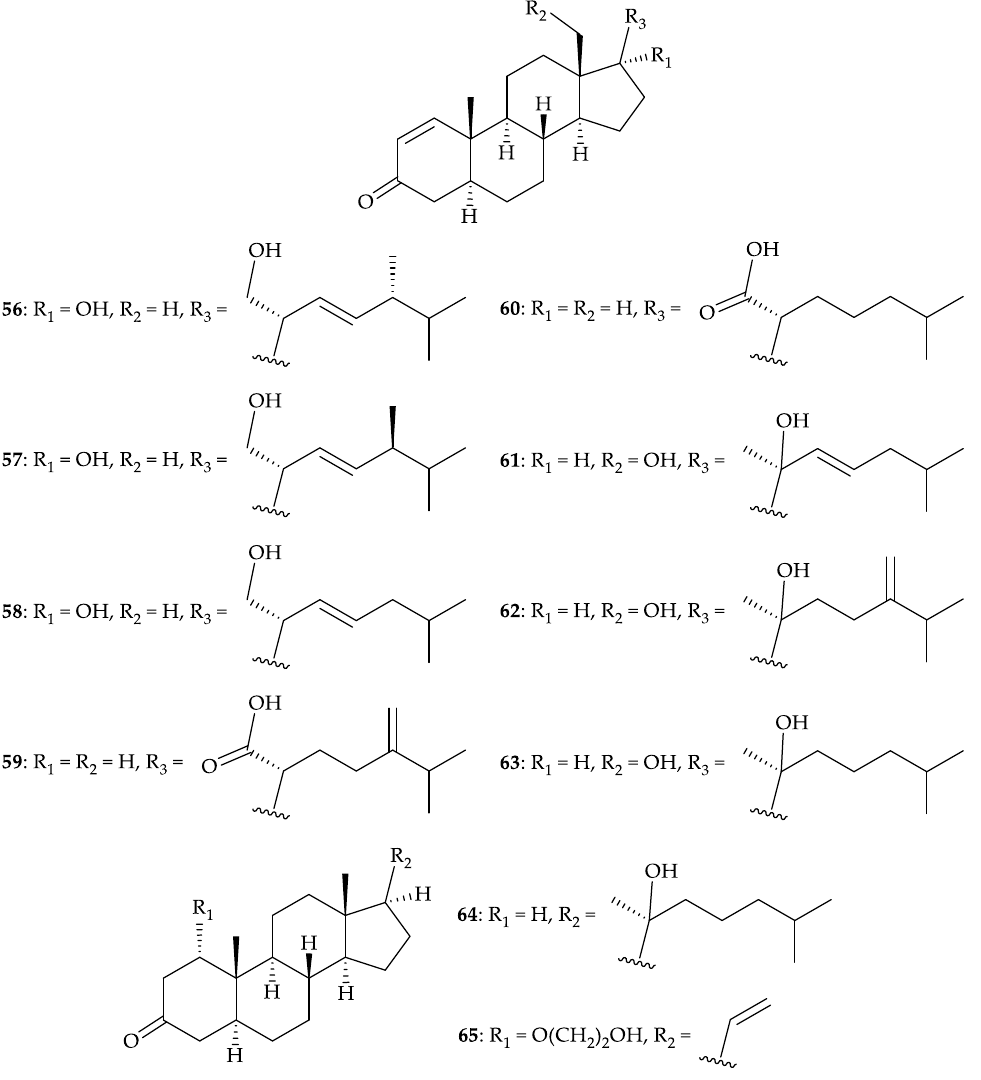
Figure 9. Structures of griffinisterones A–I ( 56 – 64 ) and griffinipregnone ( 65 ).